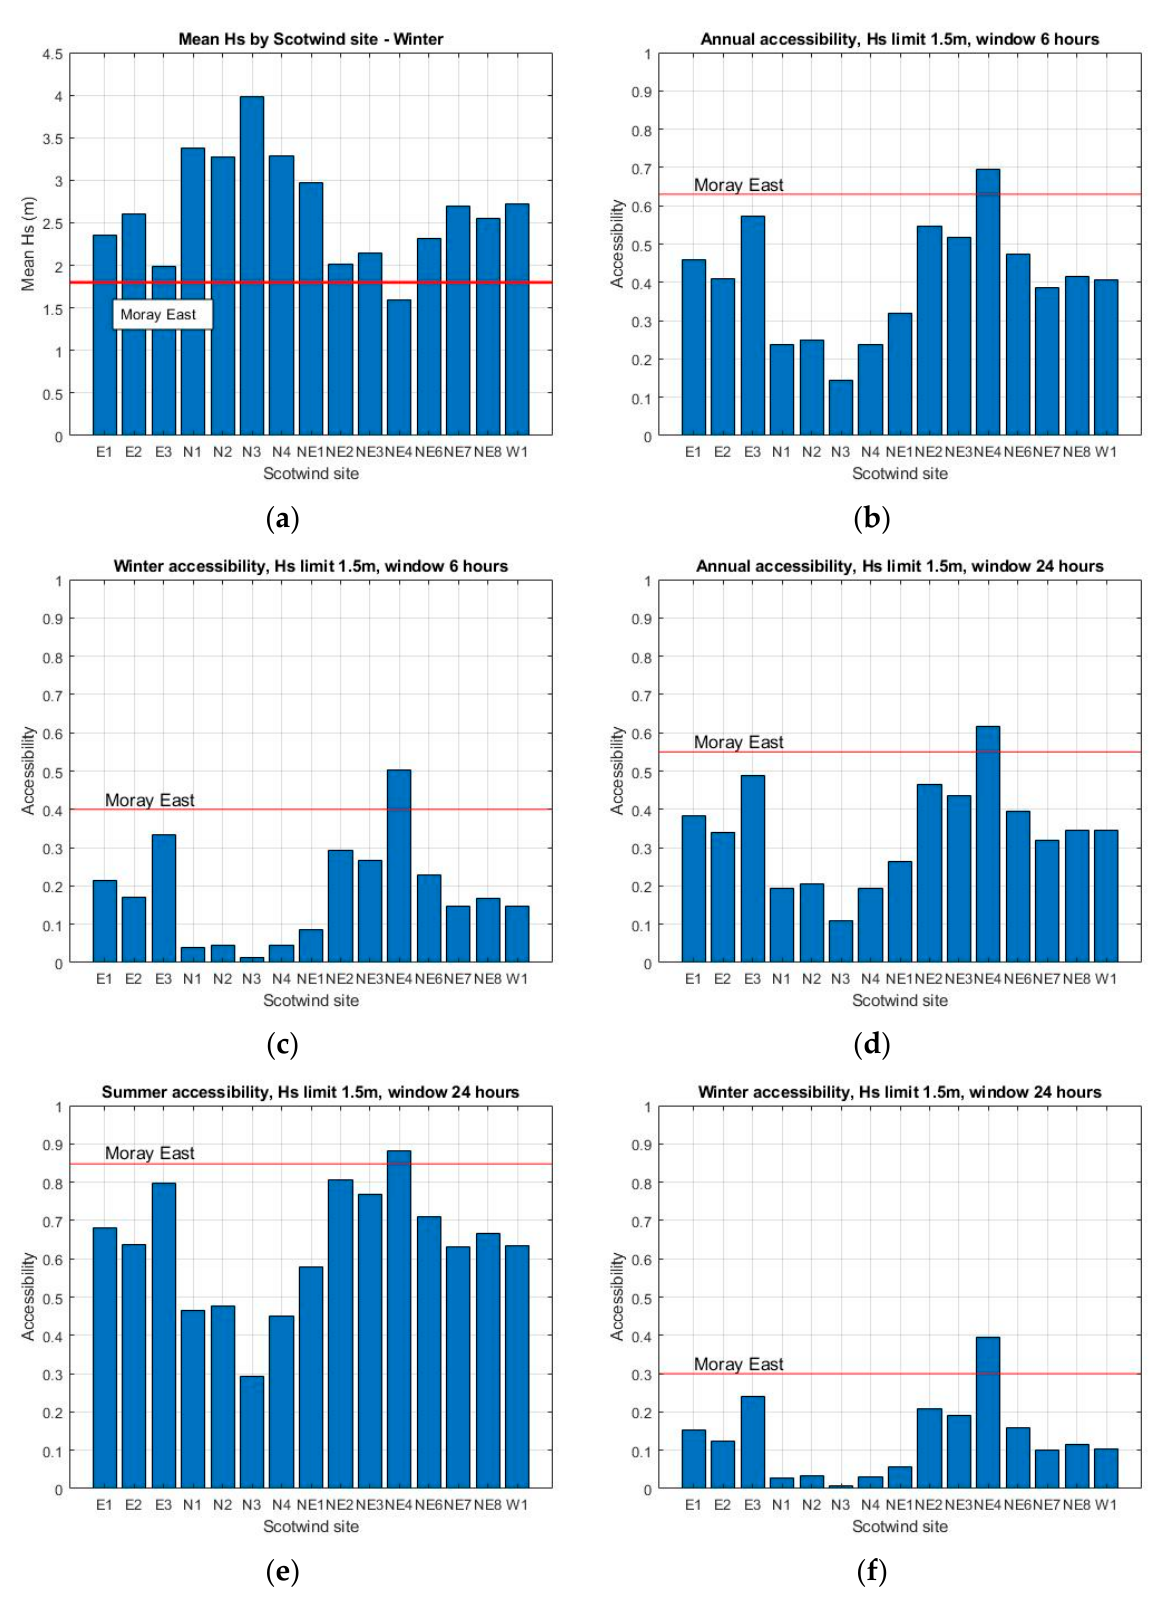
Figure 5. ( a ) mean significant wave heights in winter, ( b ) annual accessibility—H S limit of 1.5 m and 6 h weather window, ( c ) winter accessibility—H S limit of 1.5 m and 6 h weather window, ( d ) annual accessibility—H S limit of 1.5 m and 24 h weather window, ( e ) summer accessibility—H S limit of 1.5 m and 24 h weather window, ( f ) winter accessibility—H S limit of 1.5 m and 24 h weather window.